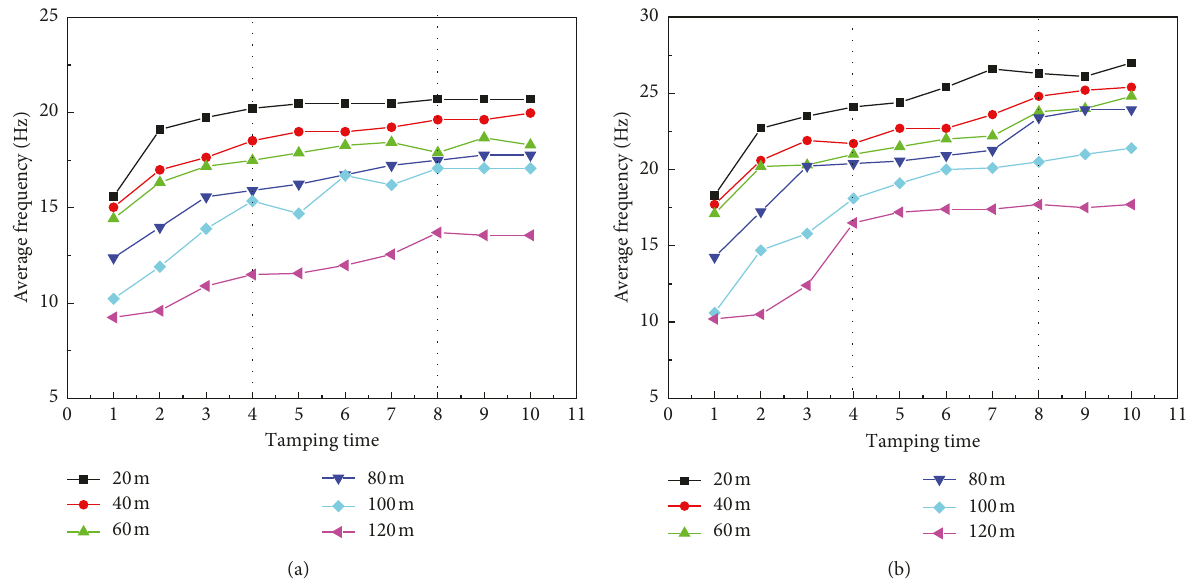
Figure 12: Relations between average frequency and tamping times at different tamping distances. (a) In radial direction. (b) In vertical direction.